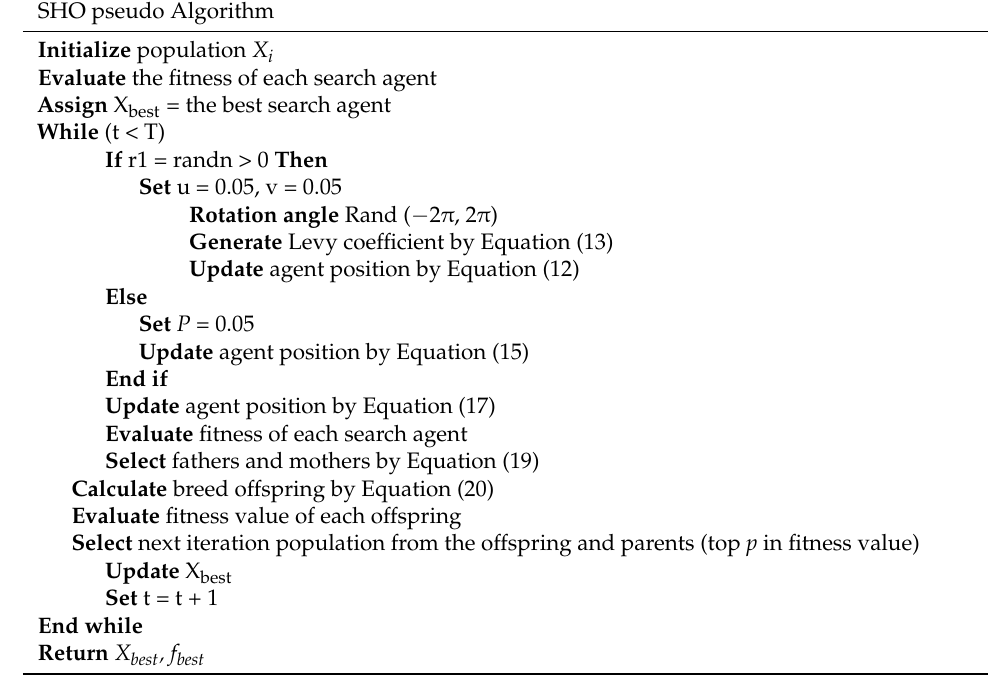
Table 4. The SHO pseudo code.